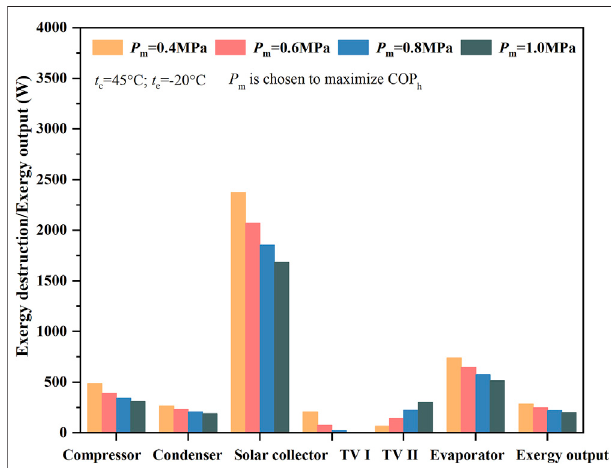
FIGURE 10 | Component exergy destructions under different intermediate pressures.